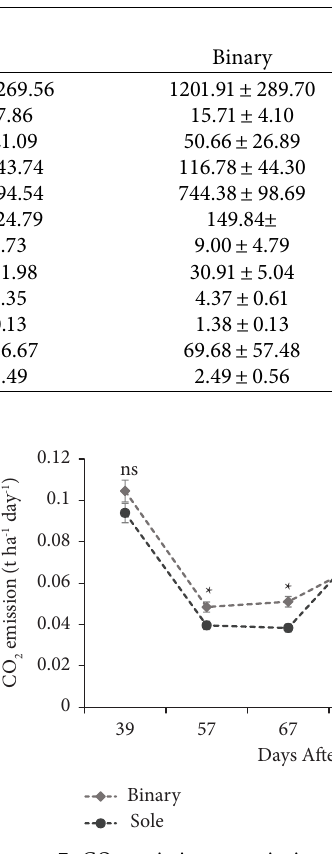
Figure 6: CO 2 emission rates in intercropping (binary) and sole cropping system during the 2018/19 cropping season at Syferkuil. ns � not signifcant; ∗ � signifcant at p ≤ 0.05. (Figure 11(b)). On average, cowpea sole emitted 0.060 t · ha − 1 · day − 1 of CO , while a combination of sorghum 2 and cowpea and sorghum sole emitted 0.057 and 0.054 t · ha − 1 · day − 1 , respectively. 0.11 t · ha − 1 · day − 1 at 39 days after planting compared to